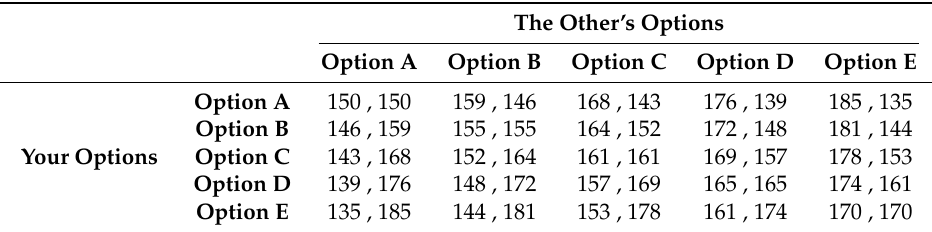
Table A1. Recomposition of task number six into a matrix game. In treatment MGT, six matrices (derived from the corresponding decomposed games) were presented to subjects and subjects were asked to choose their most preferred